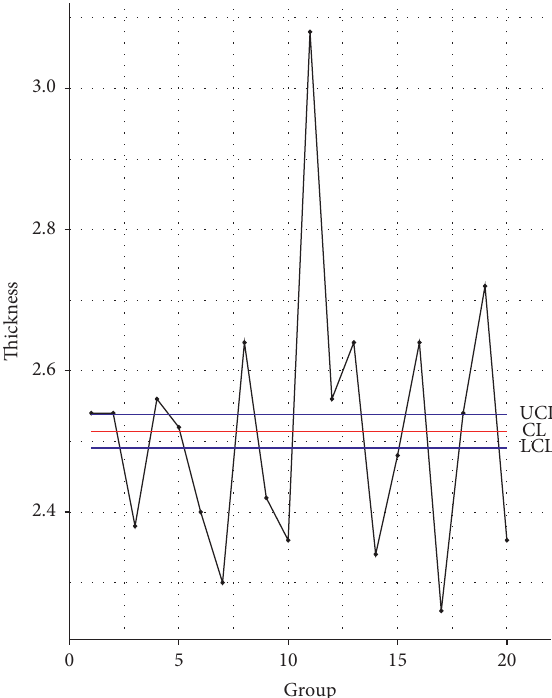
Figure 5: Gompertz skewness correction X control